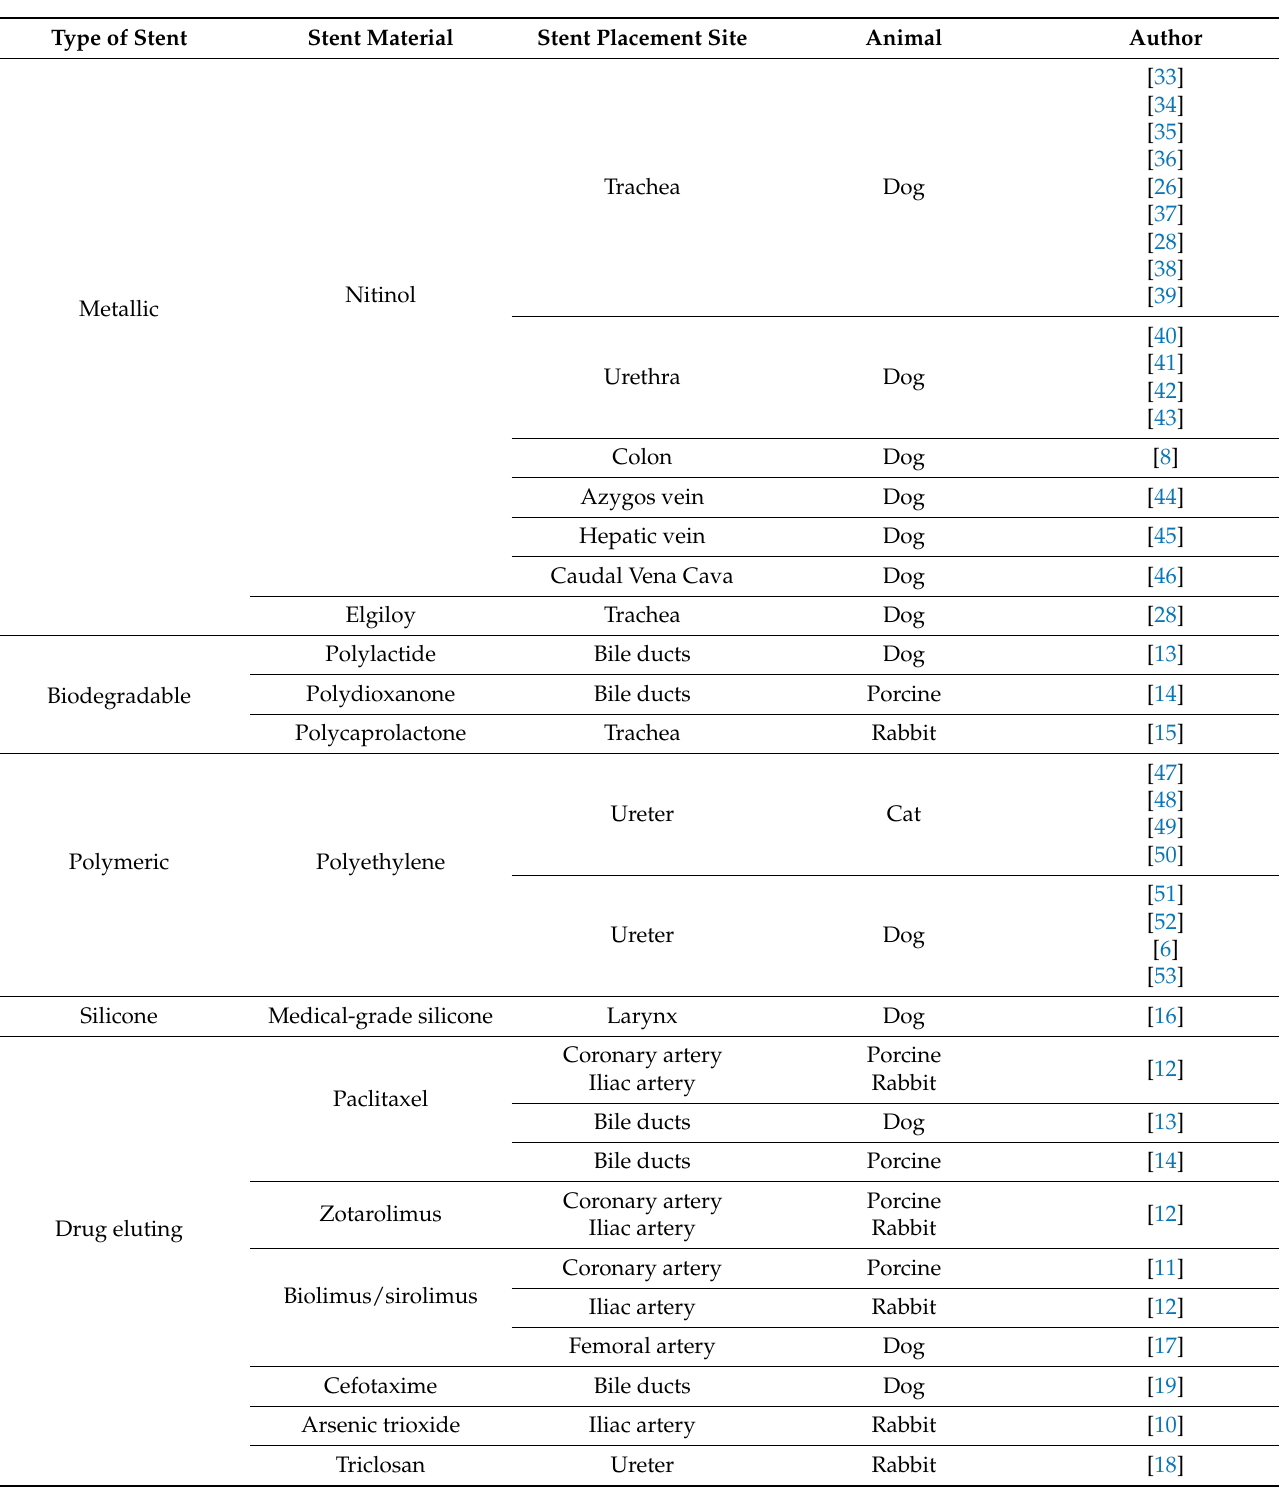
Table 1. Materials and composites used in the fabrication of stents, including the site of insertion in different animal